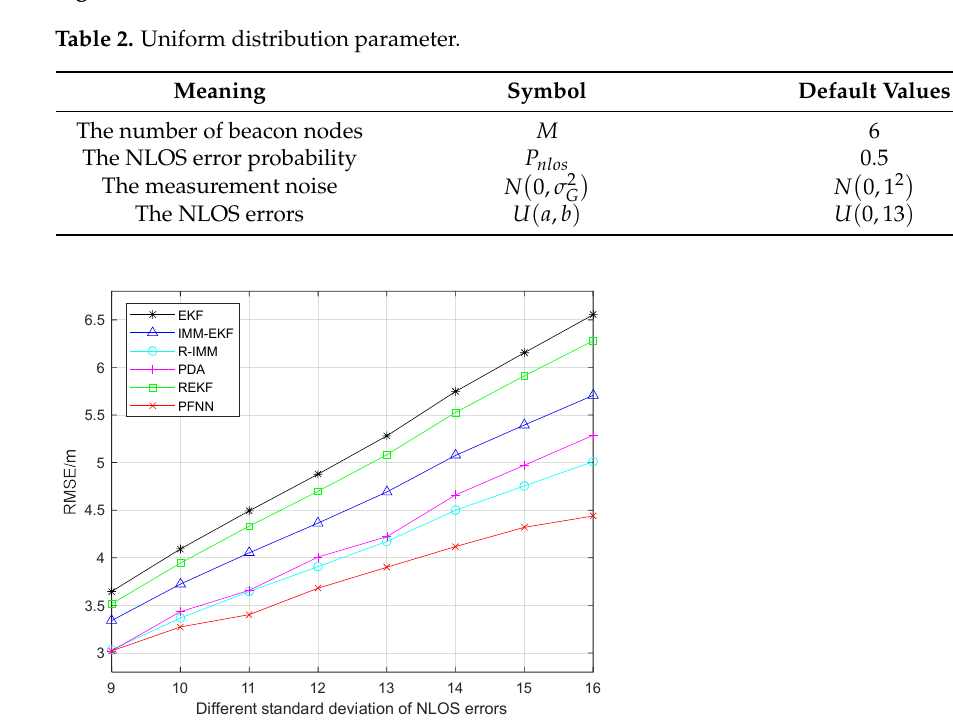
Figure 6. The RMSE versus the parameter max in the NLOS error.